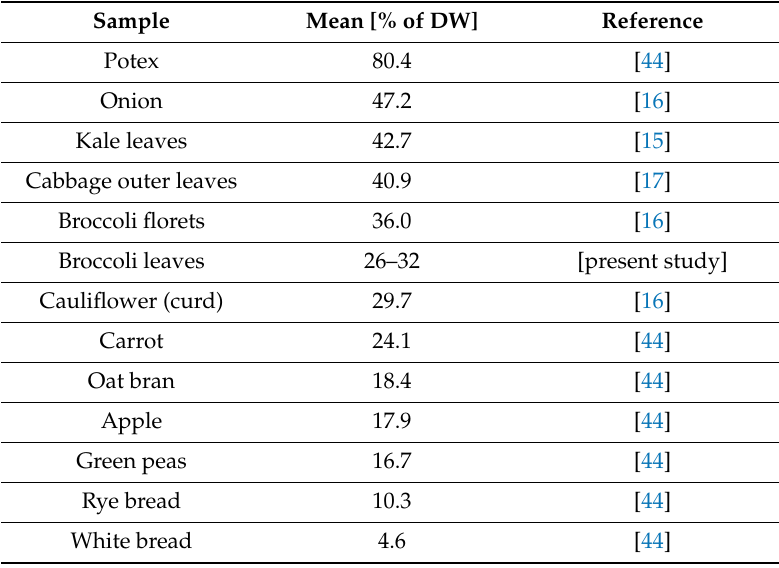
Table 6. Comparing levels of total dietary fiber in food.